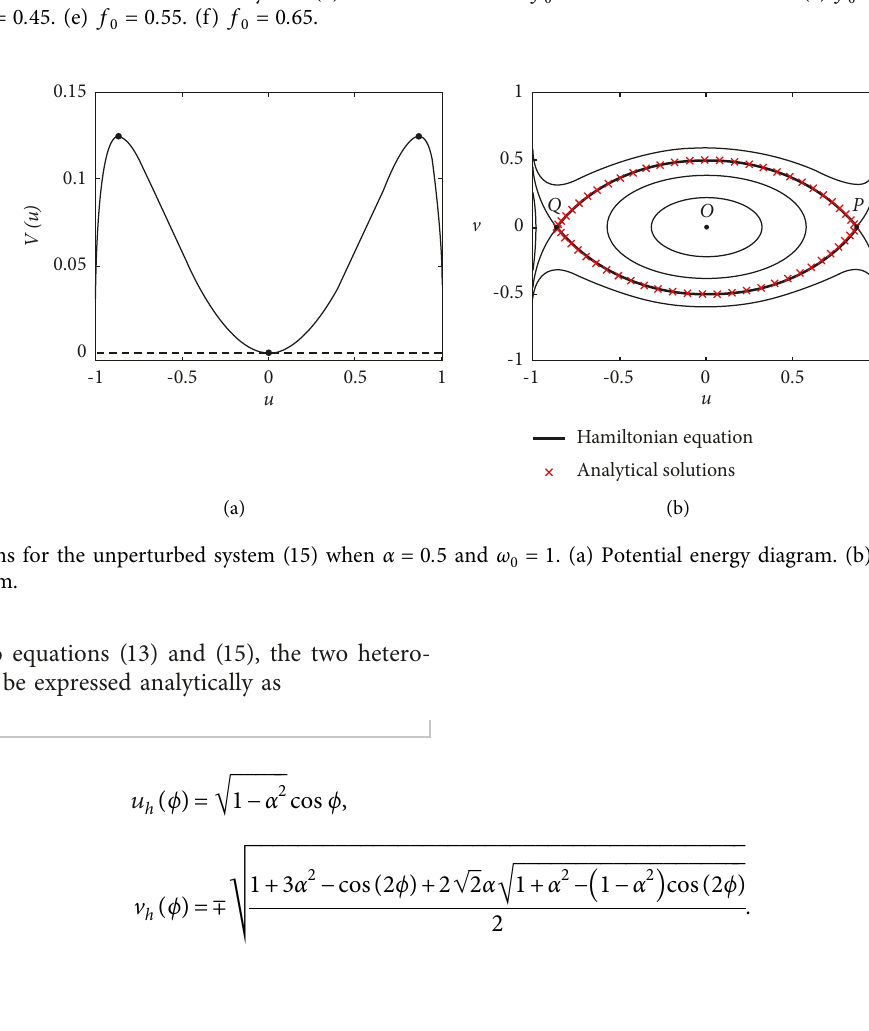
� 0 . 1. (b) f � 0 . 28. (c) 0 0